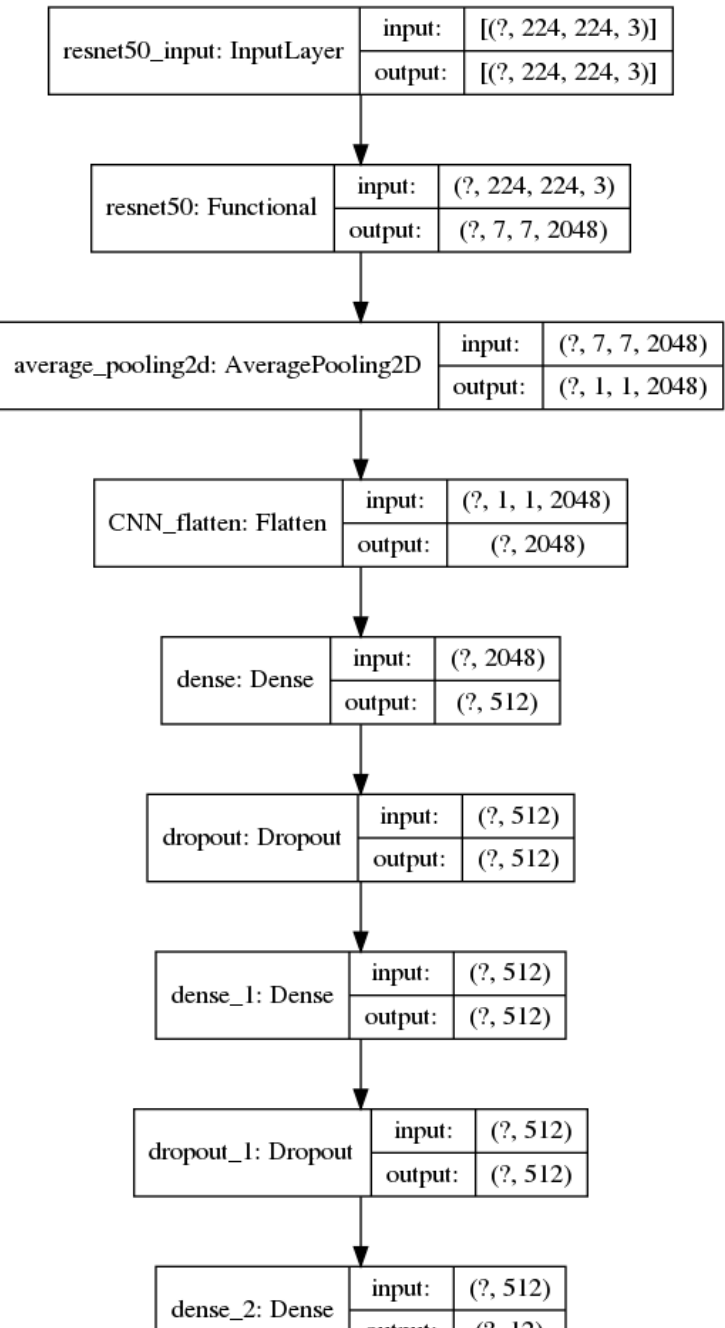
Figure 3. Schematic presentation of the top layers and modifications as applied to the ResNet–50 CNN. Since the actual input for training depends on the batch size, (?) represents this batch size. In the current manuscript the batch size used for training, validation and testing was